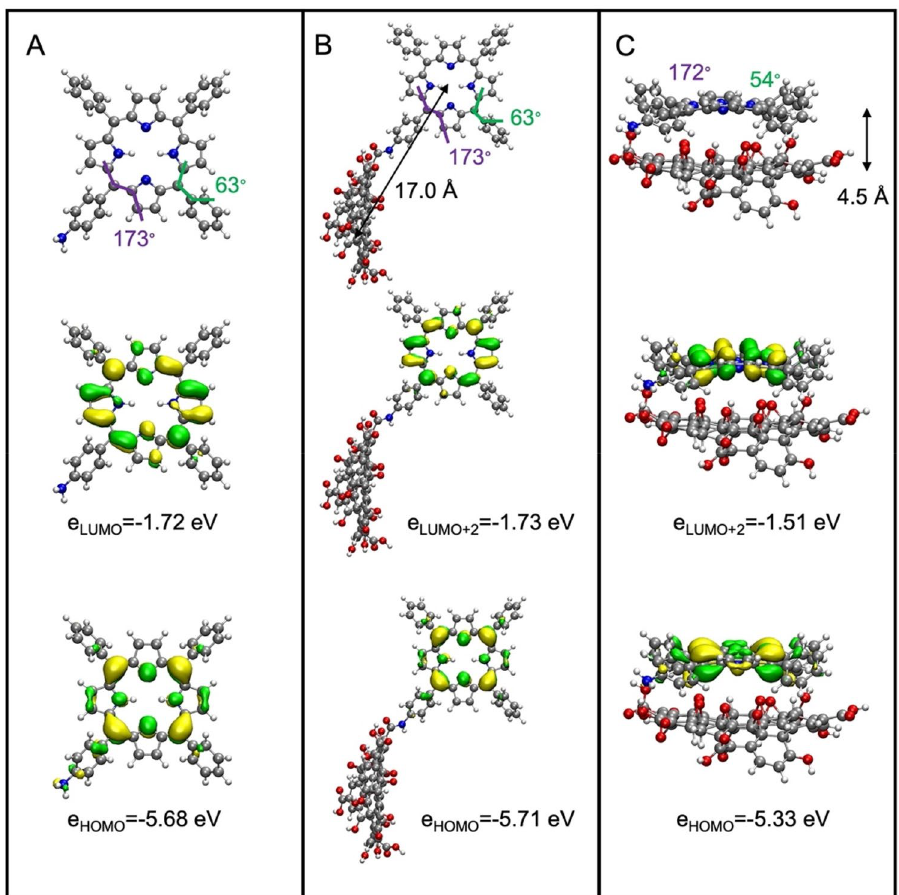
Figure 13. Calculated structures (BP86 + D3gCP/def2-TZVP; top) and selected frontier molecular orbitals strongly localized in the porphyrin moiety along with corresponding orbital energies (middle and bottom) for: ( A ) TPPNH 2 , ( B ) GO-CONHTPP, and ( C ) GO/TPPNH 2 noncovalent hybrid. Molecular orbitals were computed at BHLYP/def2-TZVP level and drawn as ± 0.03 a.u. isosurfaces. Key dihedral angles are